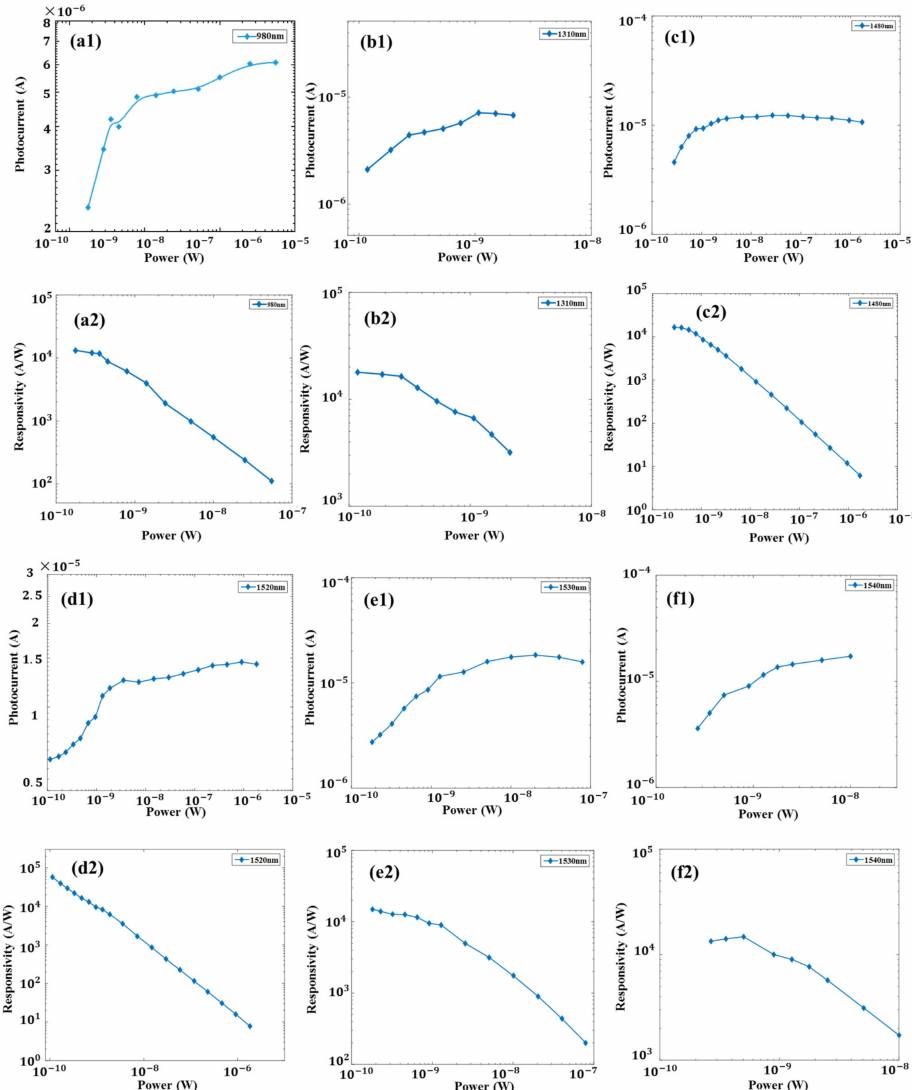
Figure A4. Photoresponse in the wavelength range of 980–1540 nm. The dependences of the photocurrents ( a1 – f1 ) and responsivities ( a2 – f2 ) on the incident optical power, ( a1 , a2 ) are in the wavelength of 980 nm, ( b1 , b2 ) are in the wavelength of 1310 nm, ( c1 , c2 ) are in the wavelength of 1450 nm, ( d1 , d2 ) are in the wavelength of 1520 nm, ( e1 , e2 ) are in the wavelength of 1530 nm, ( f1 , f2 ) are in the wavelength of 1540